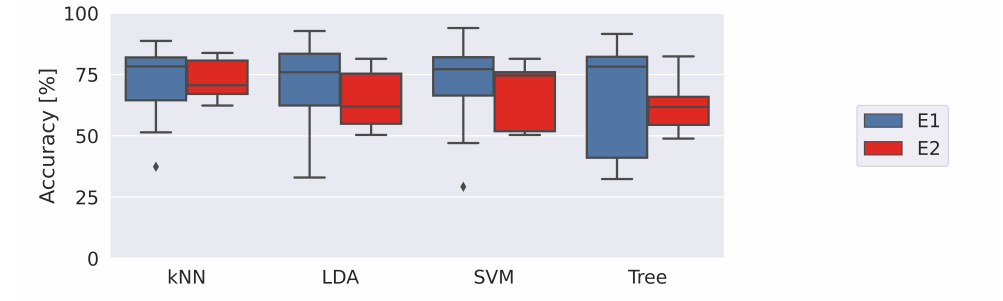
Figure 5. Accuracy returned by the classifiers trained with the PHY dataset in the two tested environmental